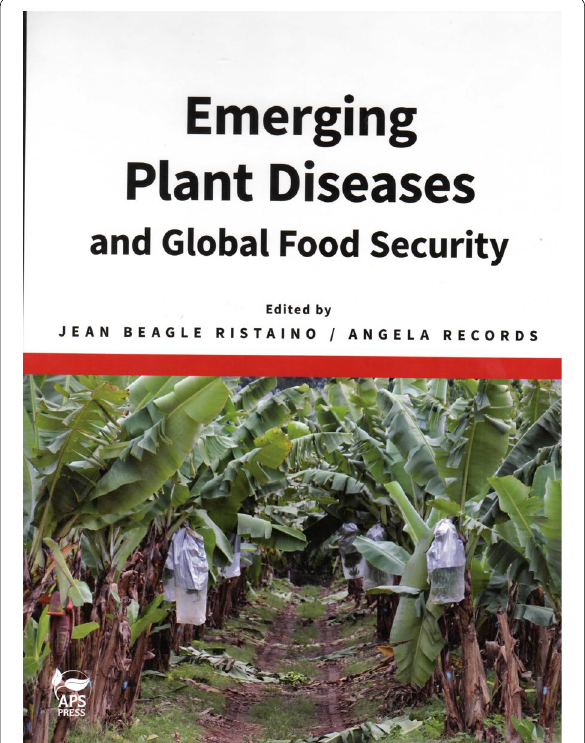
Fig. 35 Emerging Plant Diseases and Global Food Security